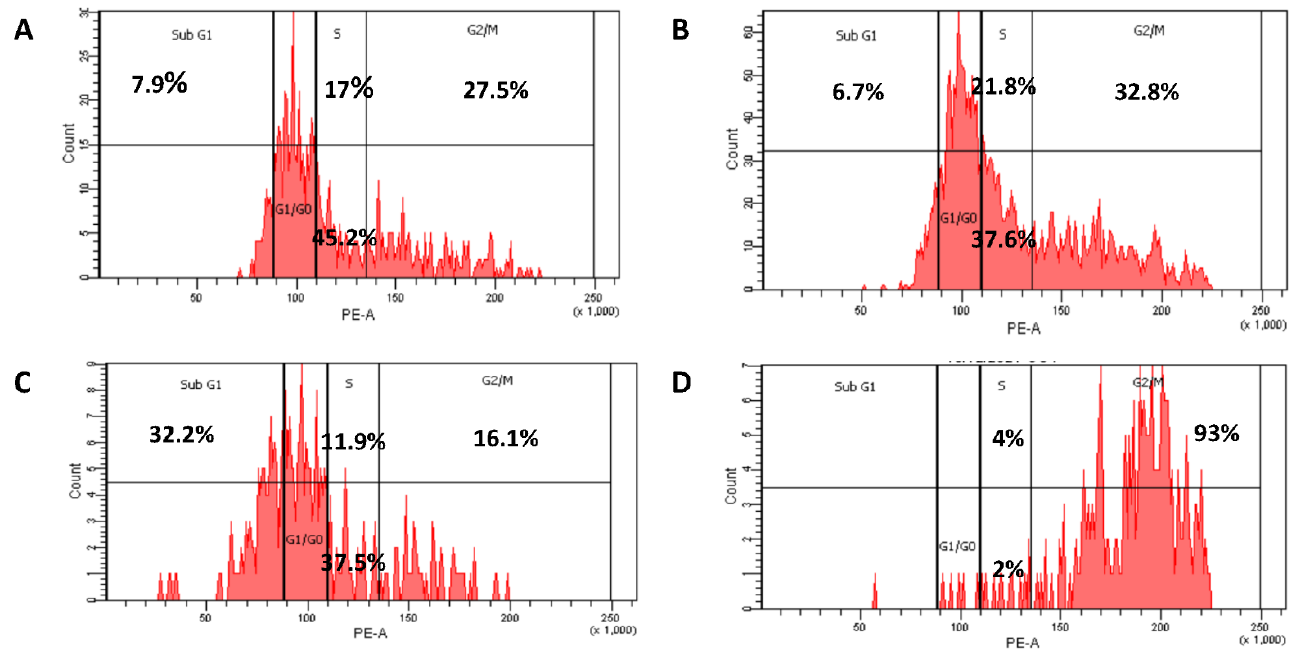
Figure 3. Cycle arrest of untreated HepG2, control ( A ); treated with 30 µ g/mL 6-MP) ( B ); 5 µ g/mL of 6-MP loaded positive charge liposomes [F1] ( C ); and drug free positive charge liposomes [F3] ( D ). HepG2 cells treated with 5 µ g/mL of 6-MP coated with positive charge liposomes showed a significant increase in G1/G0 and S phases (37.5 and 11.9%) and a dramatic decrease in G2/M phases (16.1%) as compared to HepG2 cells treated with positive charge liposomes without 6-MP, which stopped cell cycle in G1/G0 and S phases (2 and 4%) and G2/M (93%), respectively. (Figure 3C,D and Figure 4). The percentage of inhibition of proliferation of HepG2 treated with 30 µ g/mL 6-MP and 5 µ g/mL 6-MP loaded positive liposomes was found to be 65% and 80%, respectively, whereas the percentage of inhibi- tion of HepG2 treated positive liposome was 7%. HepG2 suppression by 6-MP or 6-MP liposomes occurs because 6-MP inhibited de novo ribonucleotide synthase and purine ribonucleotide interconversion and cooperated with DNA structure after 6-MP